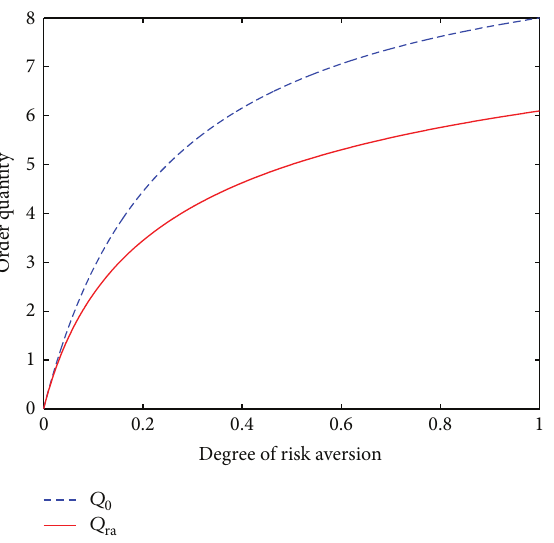
Figure 1: The effect of risk-averse level on 𝑄 0 and 𝑄